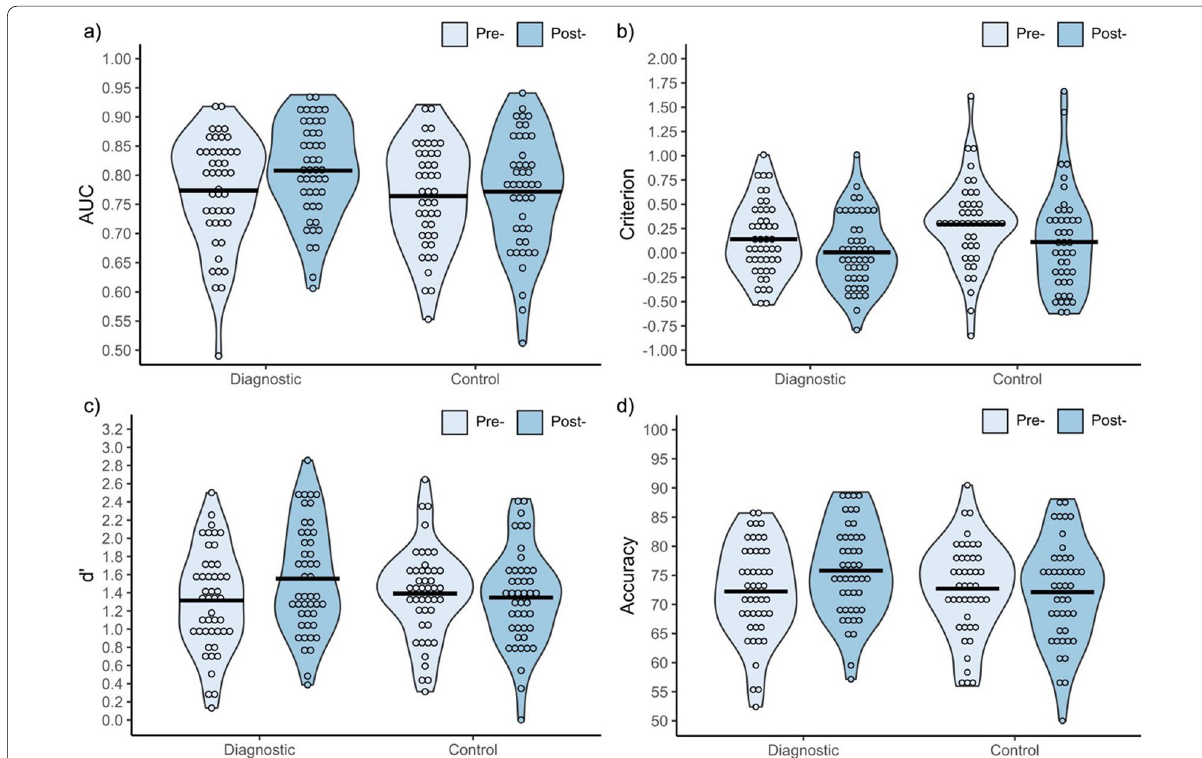
Fig. 2 Performance measures pre- and post-training for each training condition. a Area under the curve (AUC). b Response bias (criterion for declaring a match). c Sensitivity (d ′ ), d overall accuracy (%). On all figures, unfilled circles represent individual data points (visualised in 1/30 bins by default), while the horizontal black lines represent the